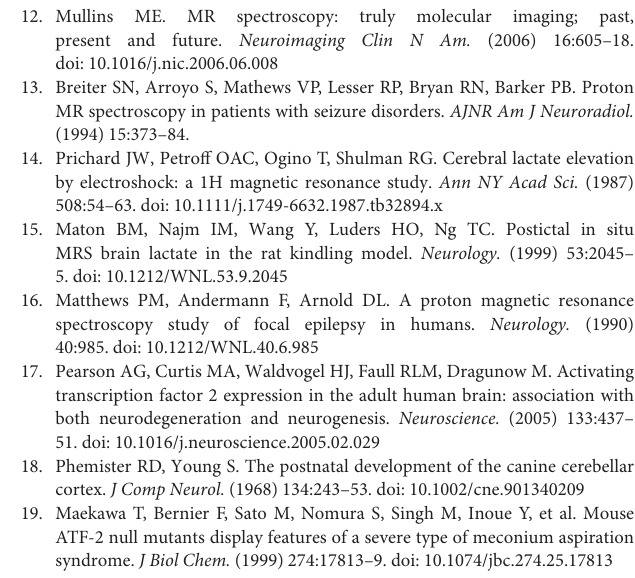
sequence. The lactate peak (1.3 ppm) and lipid peak (0.9 ppm) are seen. Cho, choline; Cr, creatine; NAA, N-acetylaspartate; mI, myo-inositol. Supplementary Table 1 | Pathogenicity prediction of the amino acid change from methionine (Met) to arginine (Arg) at residue 51 of ATF2 causing NEwS. Supplementary Video 1 | The Standard Poodle puppy having generalized seizure due to neonatal encephalopathy with seizures (NEwS). Supplementary Video 2 | The Standard Poodle puppy with NEwS displaying